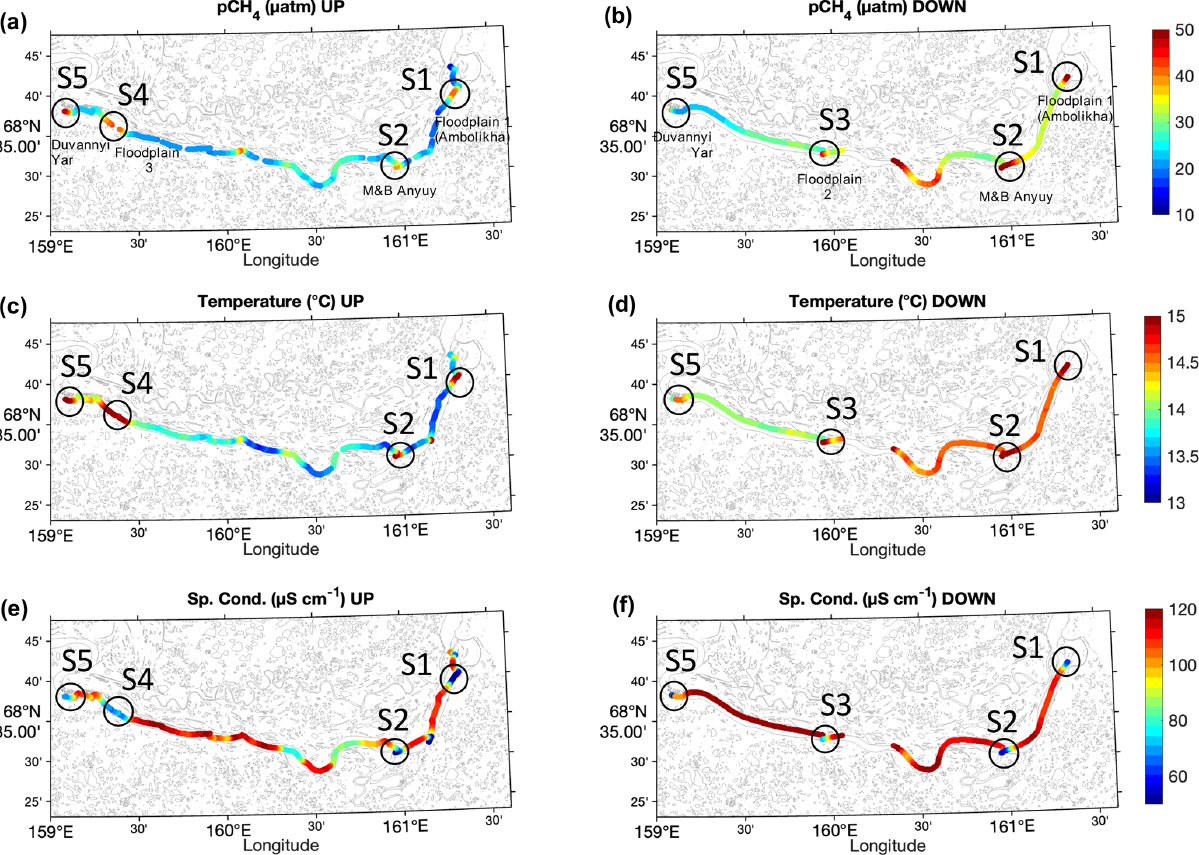
Figure 2. Spatial distribution of water properties measured along transects UP (a, c, and e) and DOWN (b, d, and f) along the main stem of the Kolyma River for p CH 4 (a and b) , T (c and d) , and κ (e and f) . The location of key sites S1 to S5 are indicated. The data corresponding to the Ambolikha River and Leonid’s stream are not